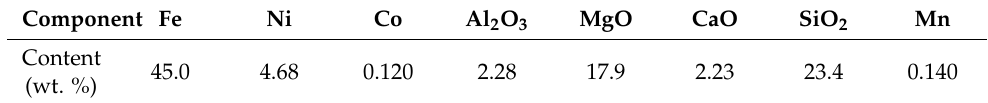
Table 2. Chemical composition of the ferronickel concentrate.